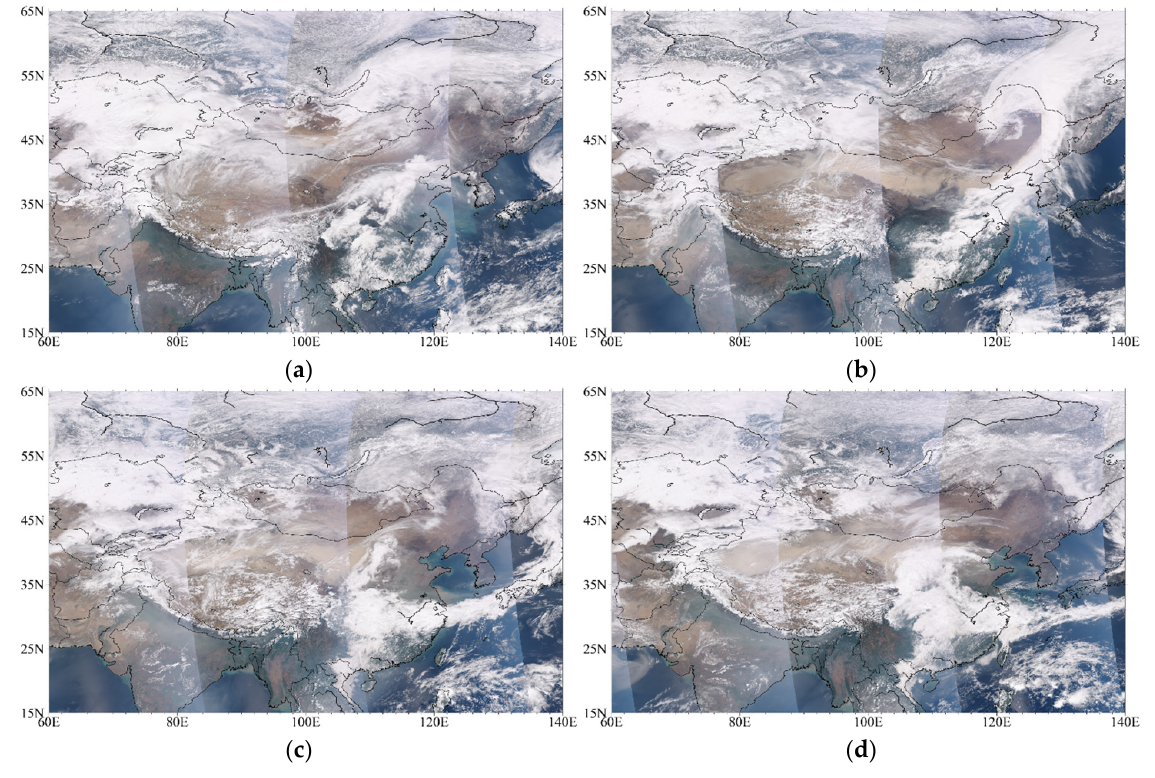
Figure 8. The VIIRS natural-color image of 14–17 March 2021. ( a ) 14 March 2021; ( b ) 15 March 2021; ( c ) 16 March 2021; ( d ) 17 March 2021.